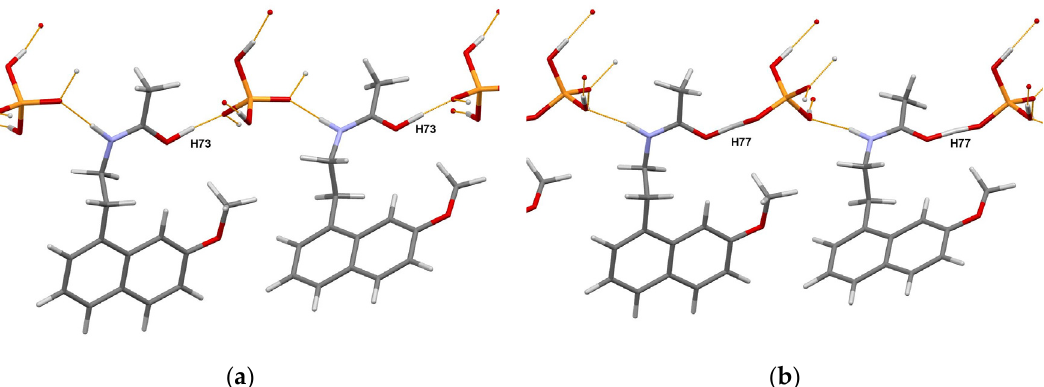
Figure 7. Portions of the crystal packings in the DFT-D2 optimized RT ( a ) and HT ( b ) forms of the agomelatine:phosphoric acid (1:1) system showing the definite position of H73 atom in RT form, and intermediate position of H77 atom (migrating proton) in HT form. Thin orange lines denote intermolecular N–H…O and O–H…O hydrogen bonds.